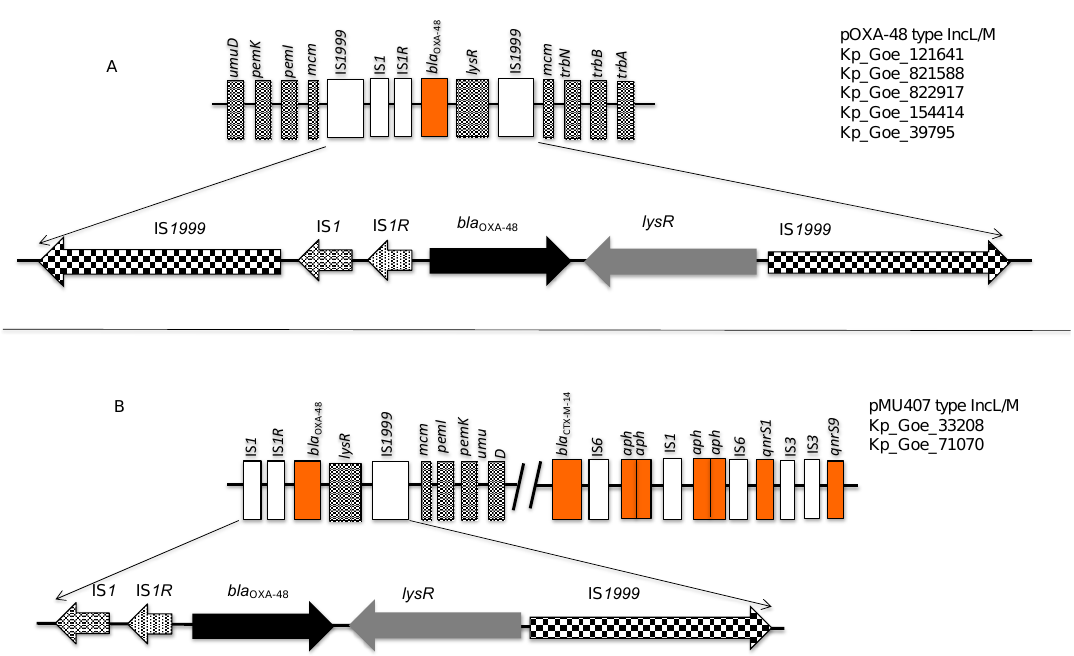
Figure 5. Comparison of transposons encoding OXA-48. ( A ) In five of the tested isolates, the bla OXA-48 gene was part of Tn 1999 ; ( B ) in the two ST101 isolates Kp_Goe_33208 and Kp_Goe_71070 the bla OXA-48 gene was part of a Tn 1999.2 transposon, which is characterized by the insertion of IS 1R into the upstream IS 1999 region.